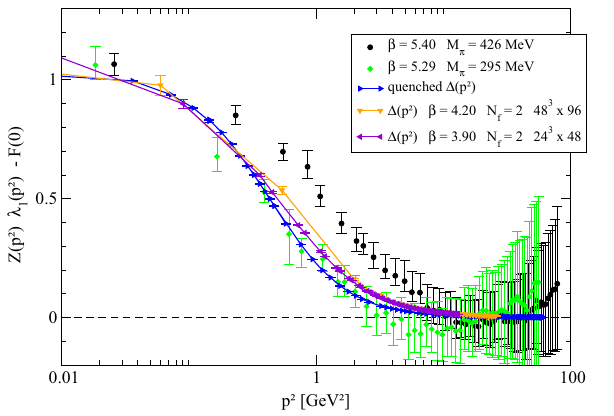
Fig. 4 Estimationofther.h.s.oftheEq.(22)multipliedby Z ( p 2 ) using the fits provided in [3]. Note the change on the sign for the λ 2 ( p 2 ) due to the Wick rotation to the Euclidean